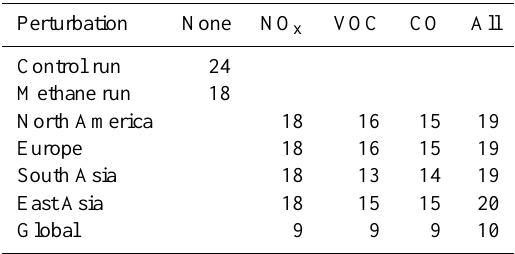
Table 1. Standard and additional simulations for the HTAP model intercomparison showing number of models contributing results for O 3